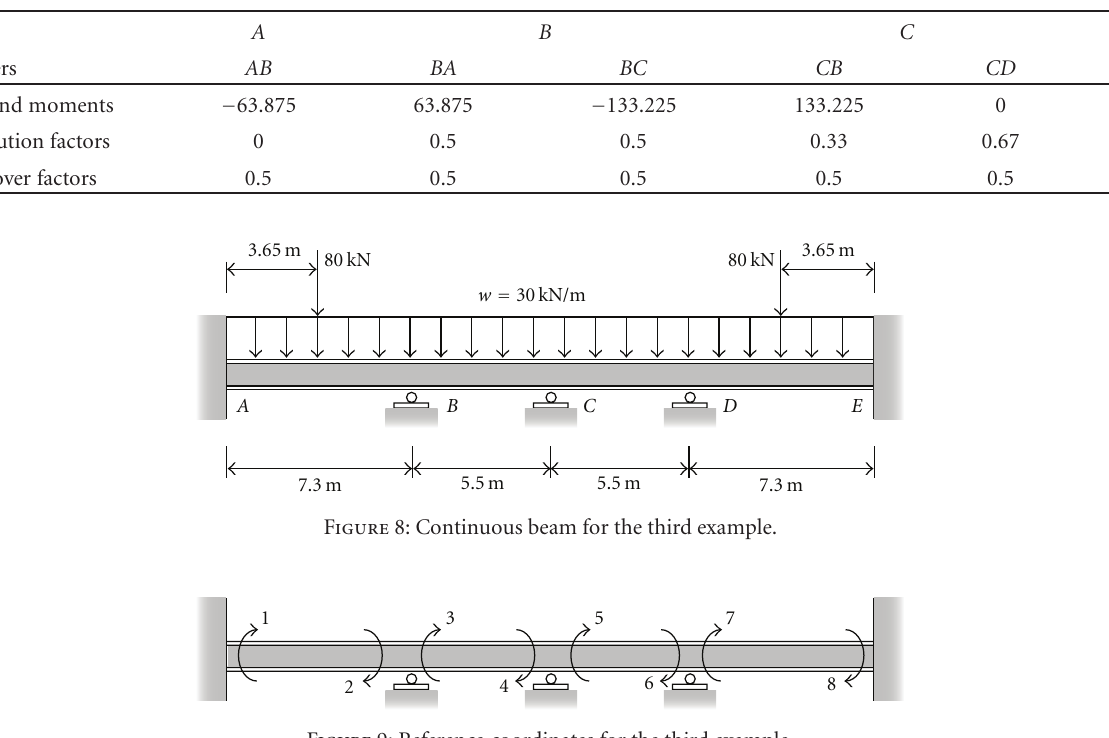
Figure 9: Reference coordinates for the third example.